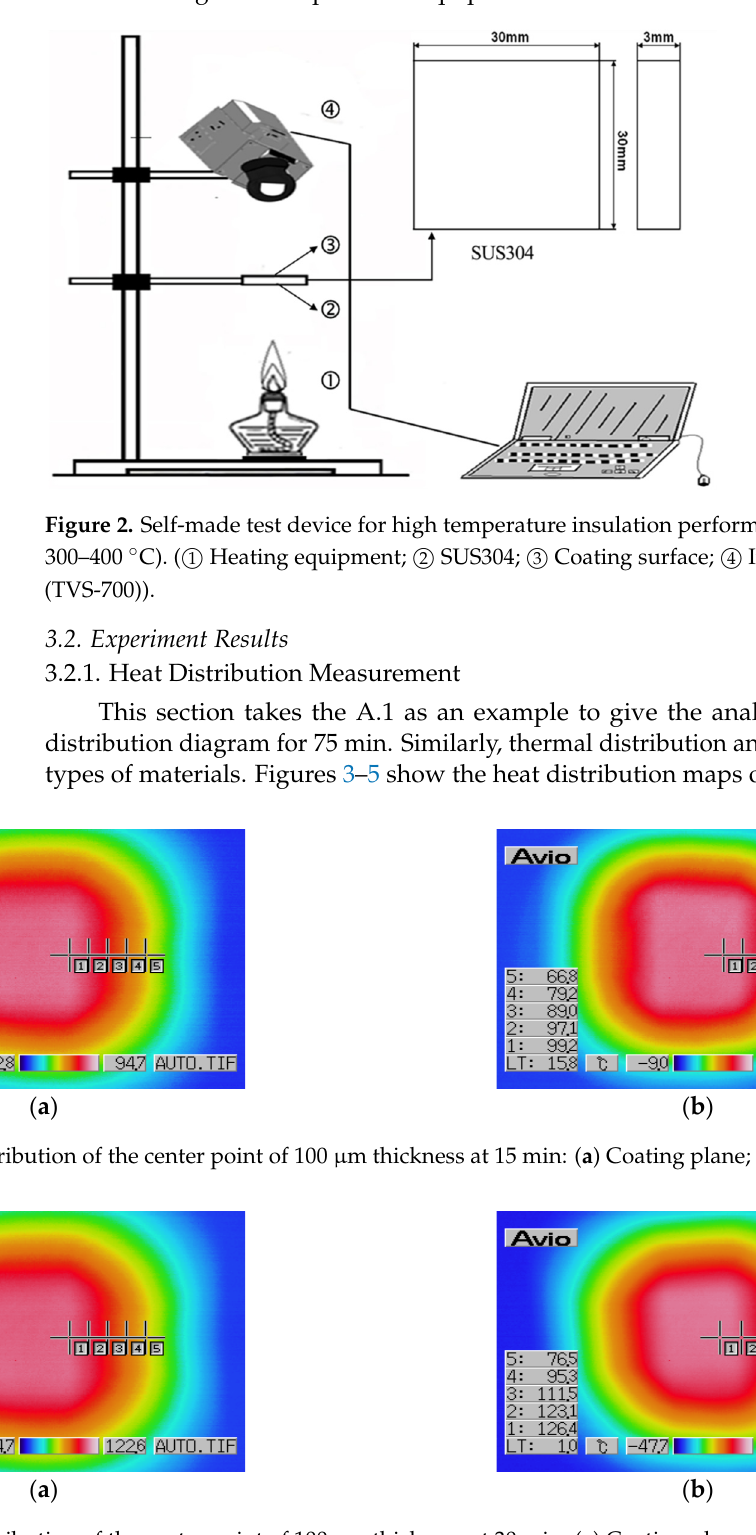
Figure 4. Heat distribution of the center point of 100 µ m thickness at 30 min: ( a ) Coating plane; ( b ) SUS304